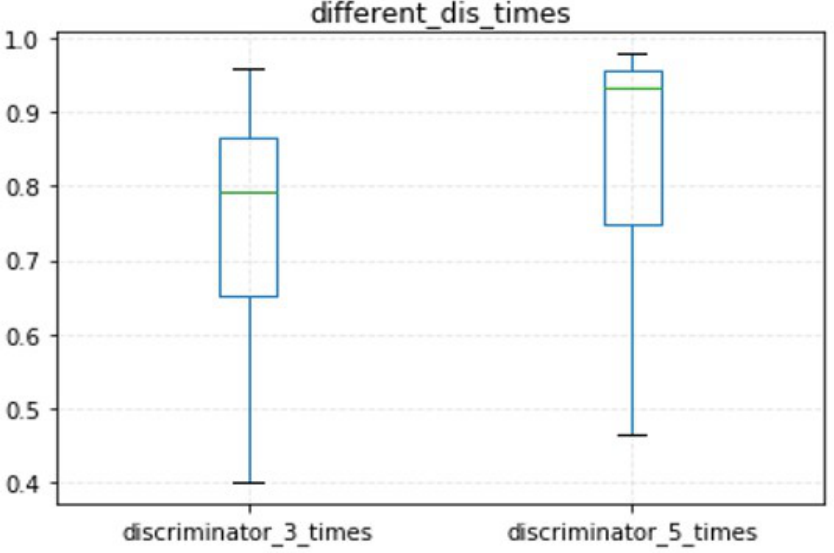
Figure 16. AUC average box and whisker after model training 20 times with different training times.